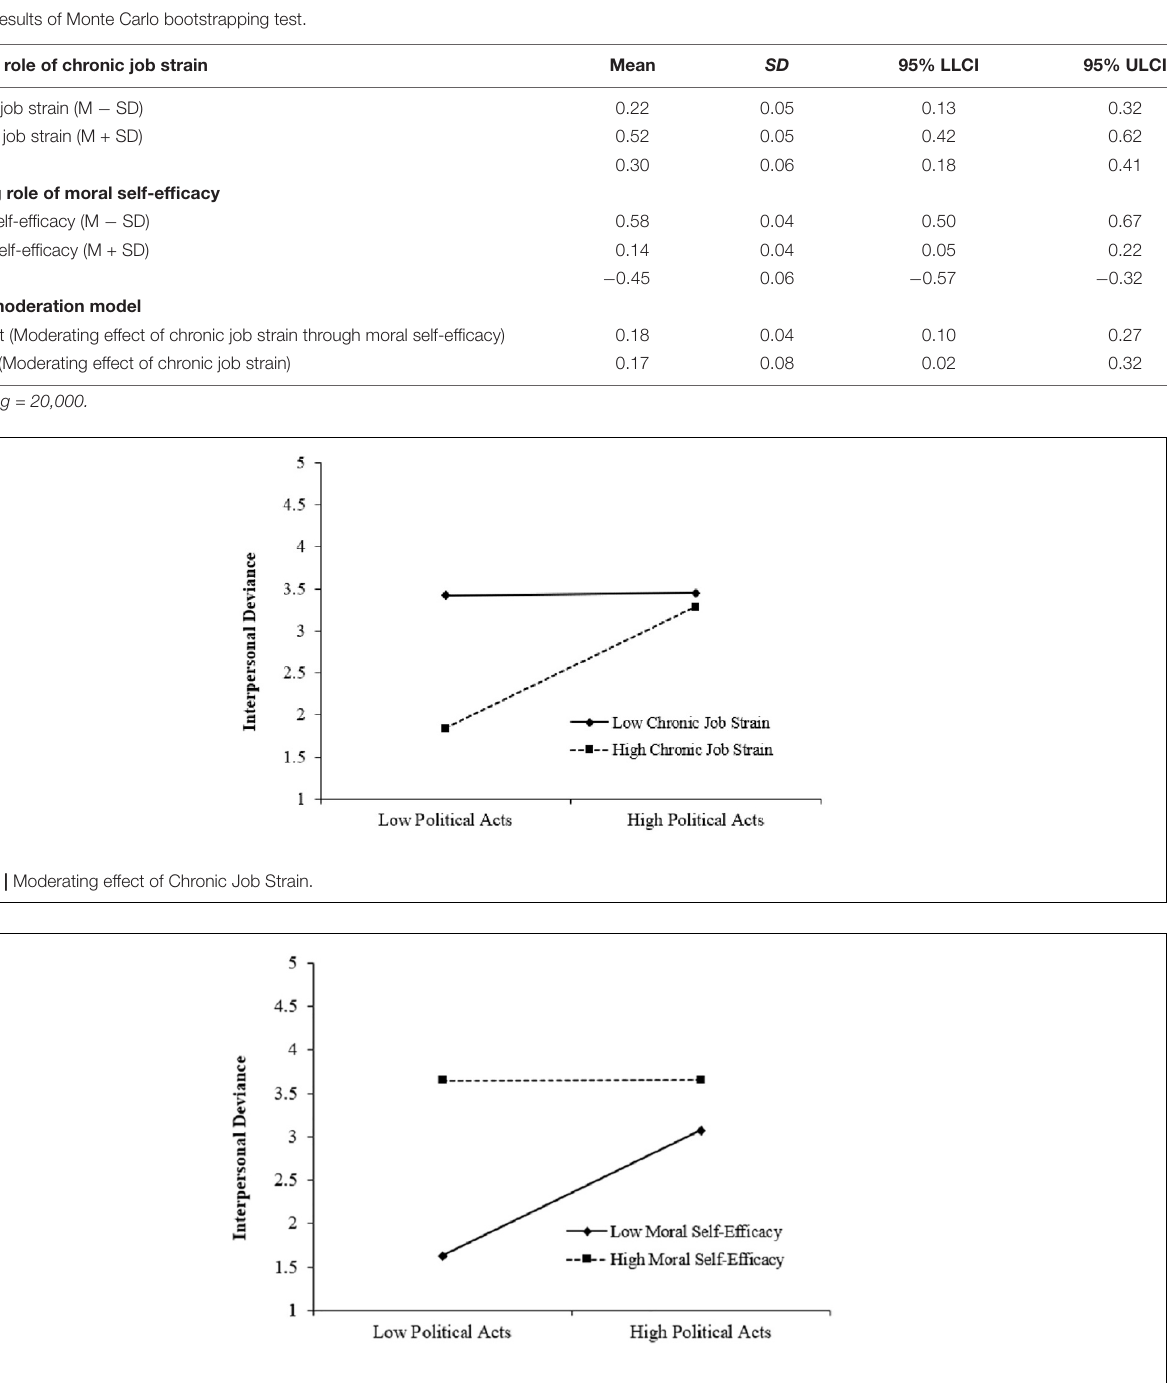
FIGURE 3 | Moderating effect of moral